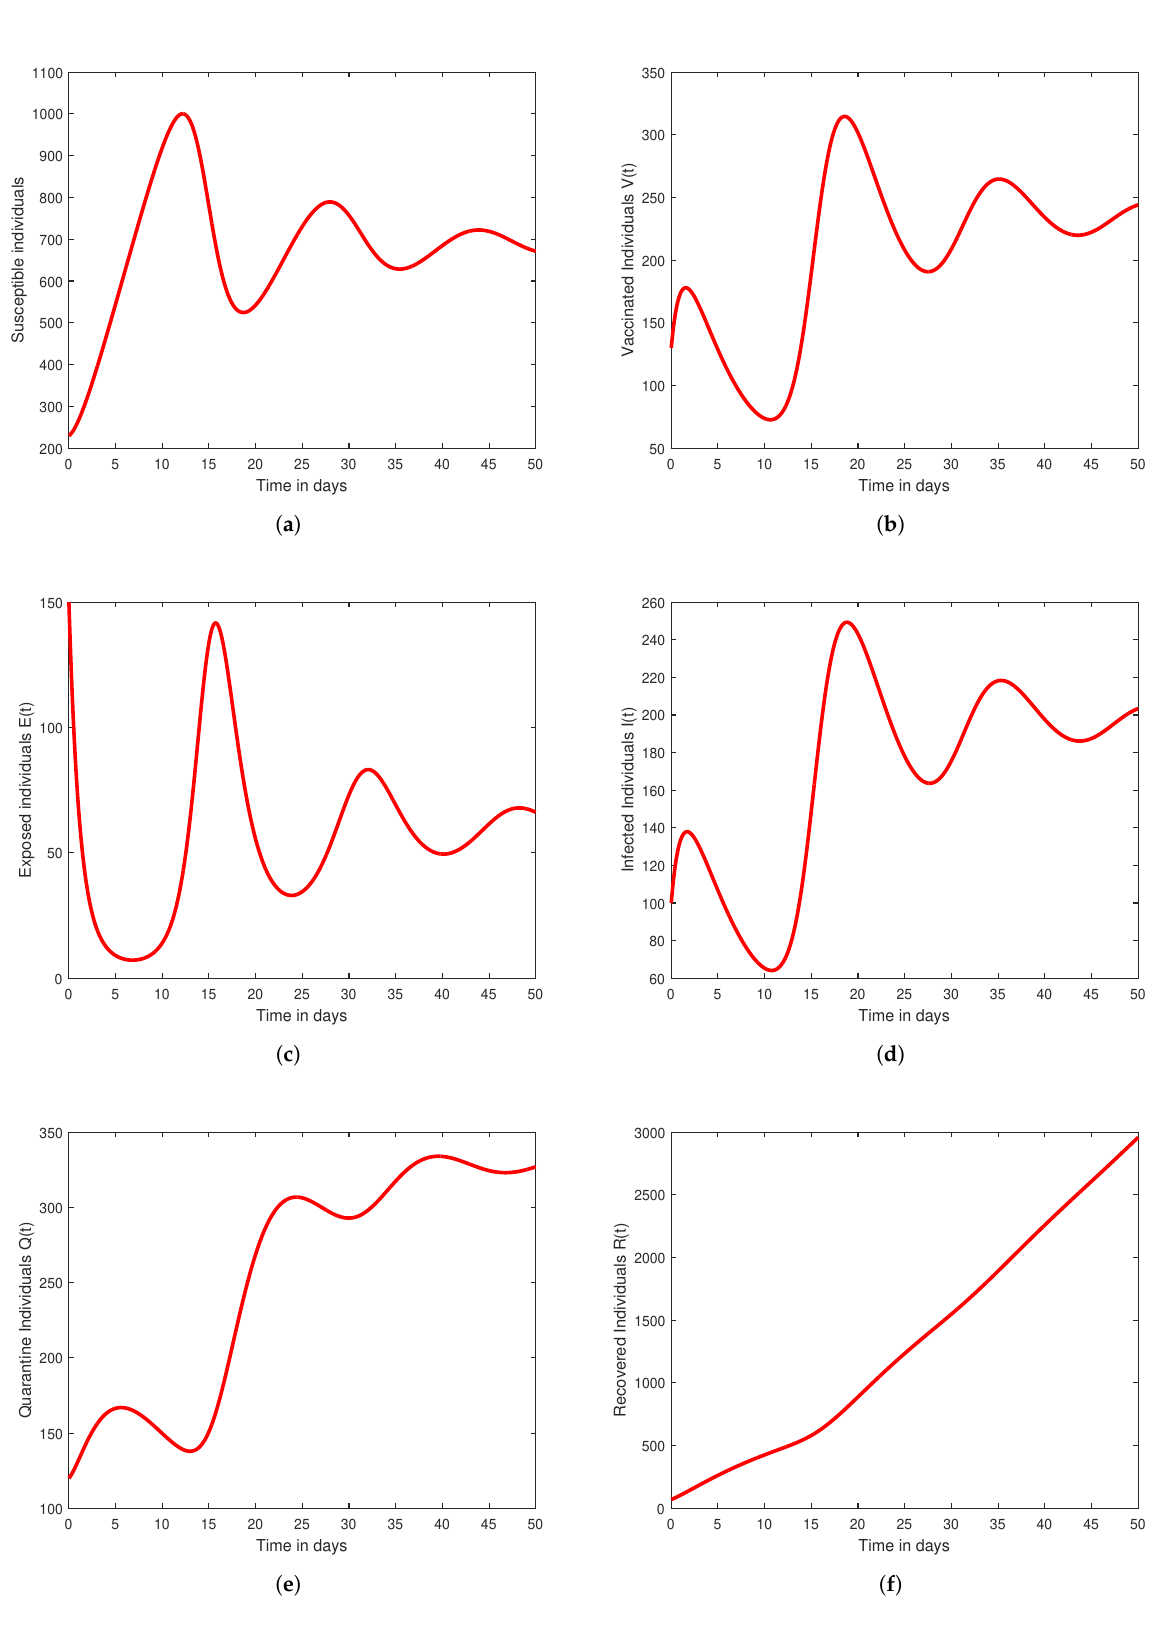
Figure 4. The caputo version of the fractional model’s behavior for each state variable is depicted in the figure at δ = 0.95. Furthermore, the figures ( a – f ) represents susceptible people S ( t ) , vaccinated people V ( t ) , exposed people E ( t ) , infectious people I ( t ) , quarantined people Q ( t ) , and recovered people R ( t )